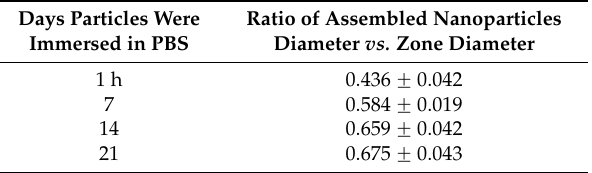
Table 1 . Zone of inhibitions measured for CHX-encapsulated nanoparticles filtered from phosphate buffer saline (PBS). The values indicate the results obtained in three trials averaged together.